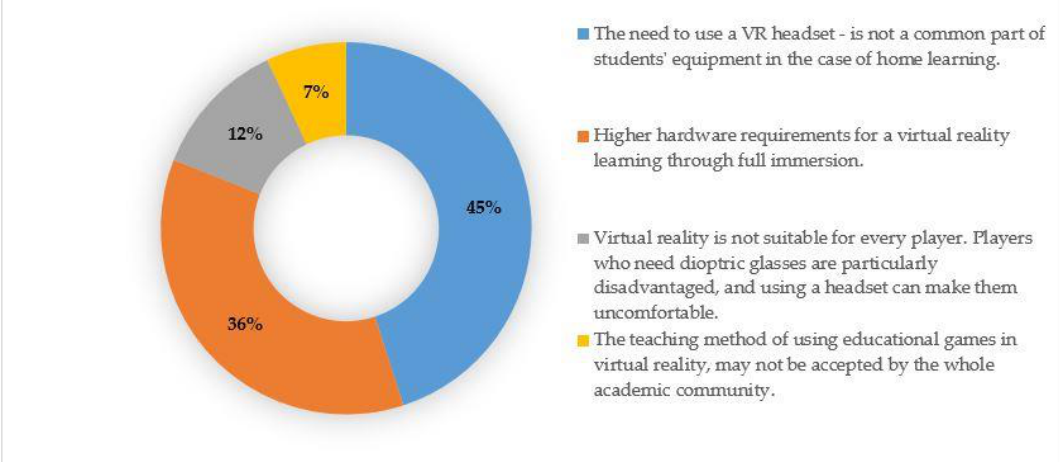
Figure 19. Subjective evaluation of disadvantages of educational games.